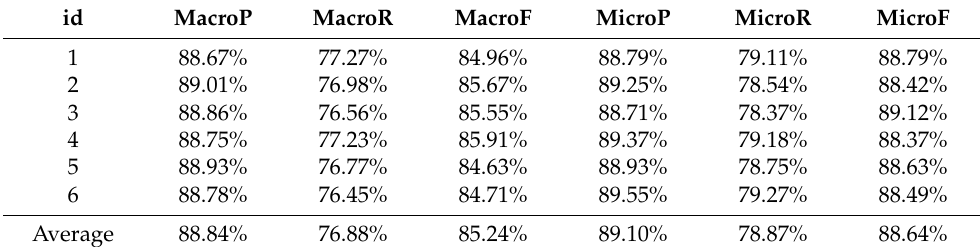
Table 2. Cross-validation result analysis table.